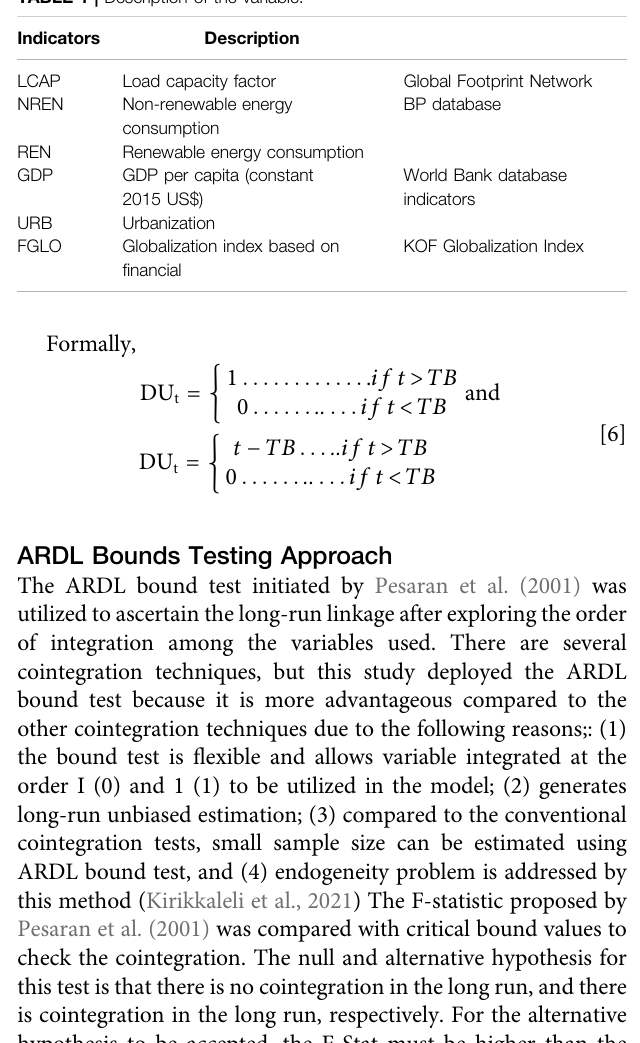
TABLE 1 | Description of the